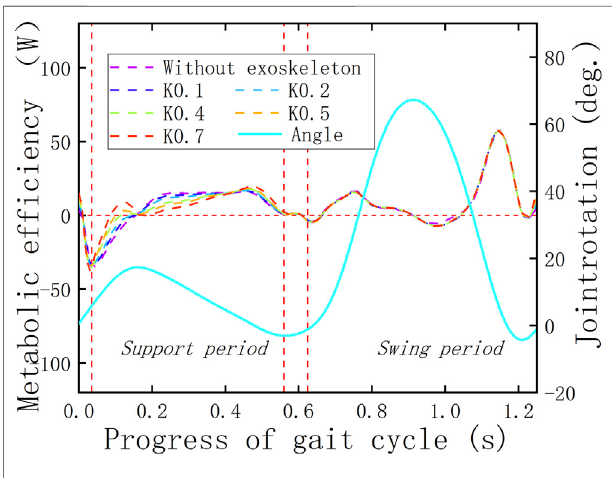
FIGURE 13 | Veri fi cation of the HESM.